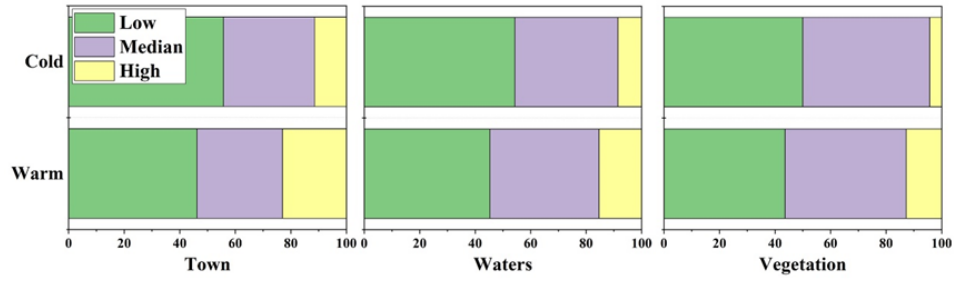
Figure 10. Seasonal distributions of the probability of occurrence of the water vapor range on different surfaces.